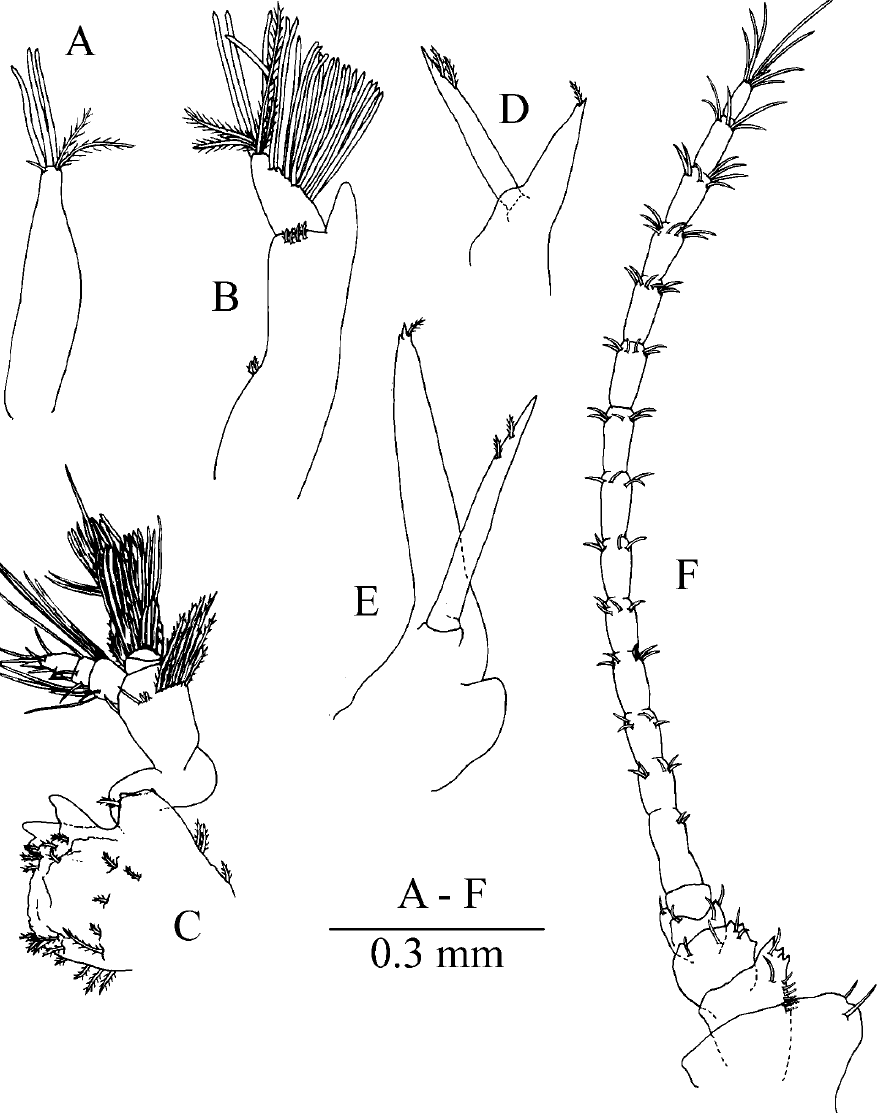
imens measured = 10. Specimens examined =